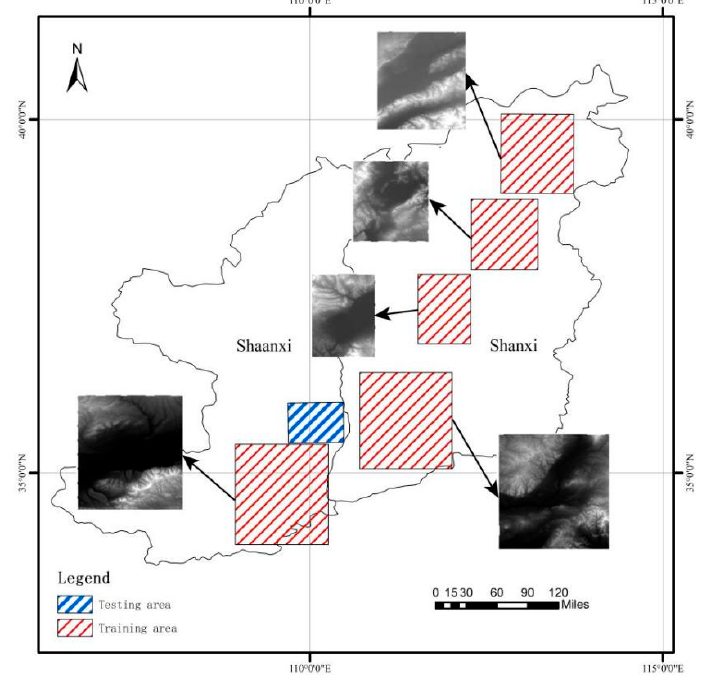
Figure 4. Location of the study area with locations of the DEM data used for the experiments.